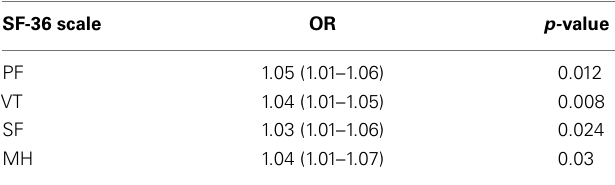
Table 4 | Odd ratio (OR) and p- values for SF-36 scales for “changes” in GHQ-12 status (from negative to positive)